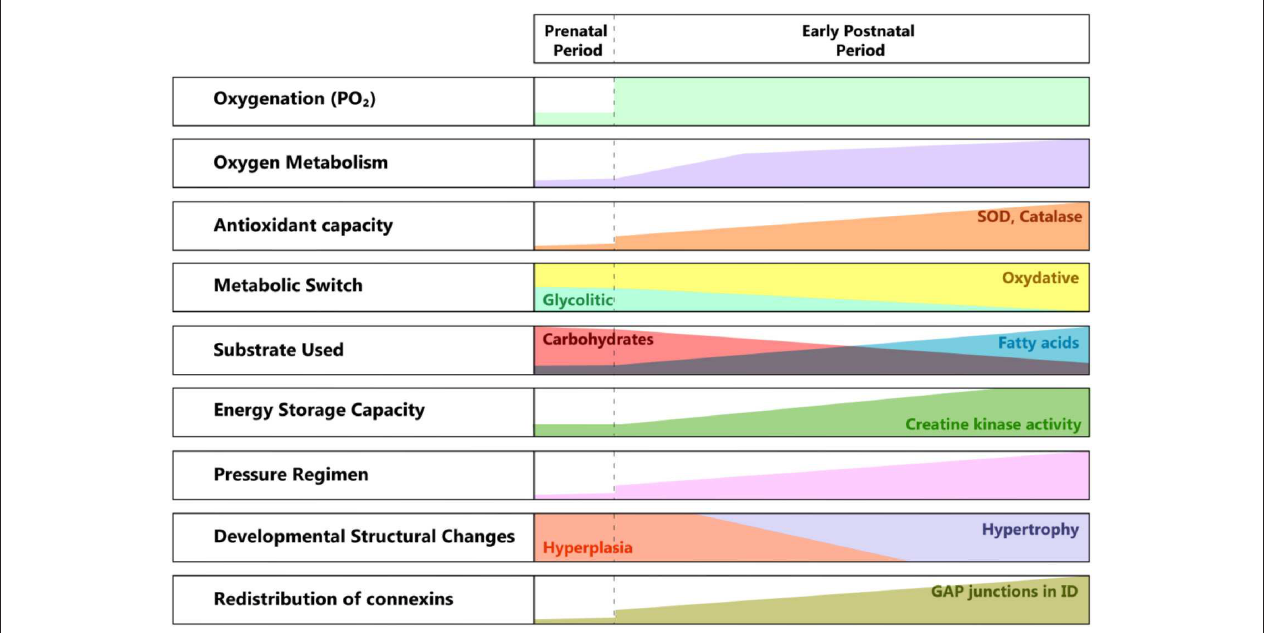
FIGURE 2 | Developmental changes from pre to postnatal periods. SOD, superoxide dismutase; ID, intercalated disk; PO2, partial pressure of oxygen.